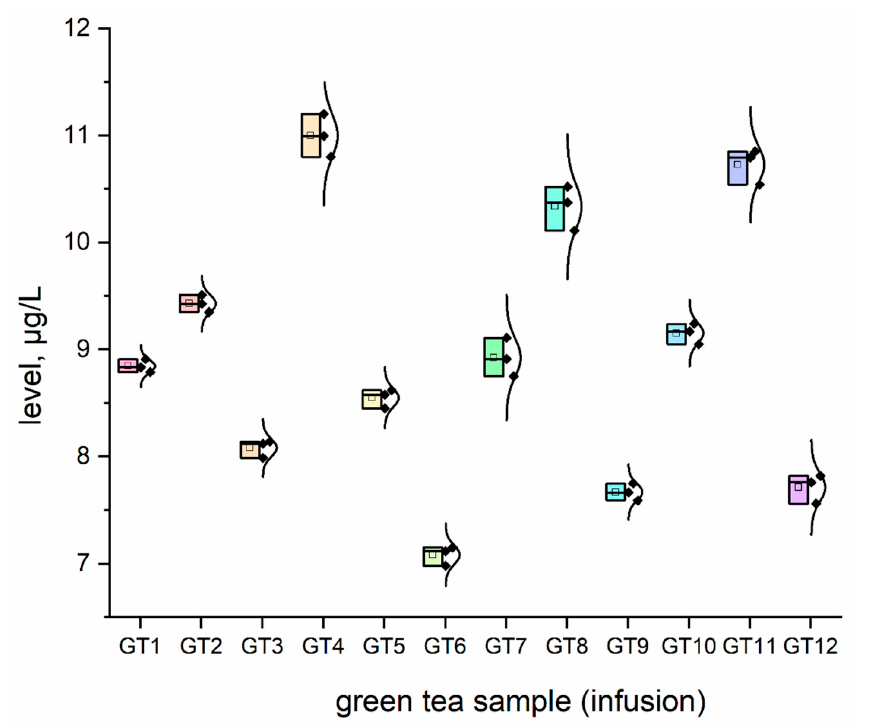
Figure 2. The plot as a box chart, with a normal distribution curve for Cr concentration ( μ g/L) in analysed green tea samples (infusions; GT1–GT12). The colors indicate the results for the individual tested samples, the symbol indicates the standard deviation.